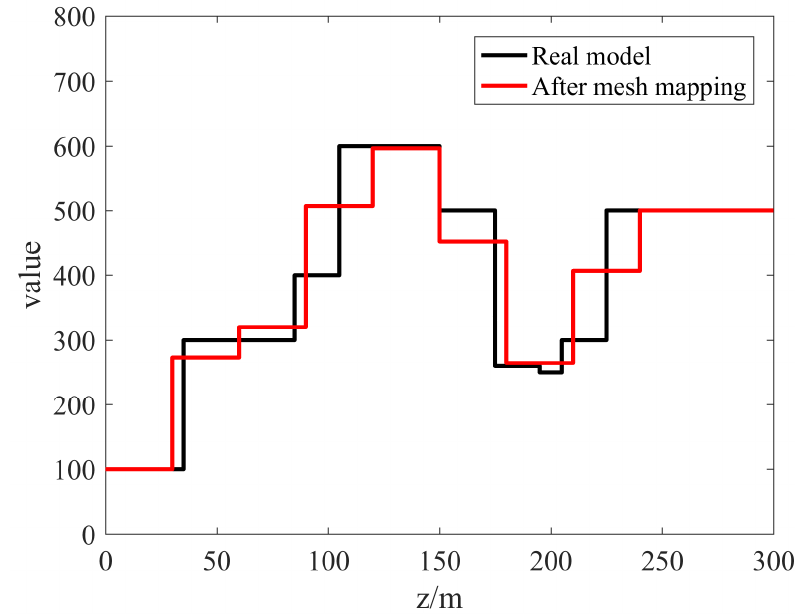
Figure 4. The comparison between the true model and the model after mesh mapping. Table 1. Parameters of the original model.